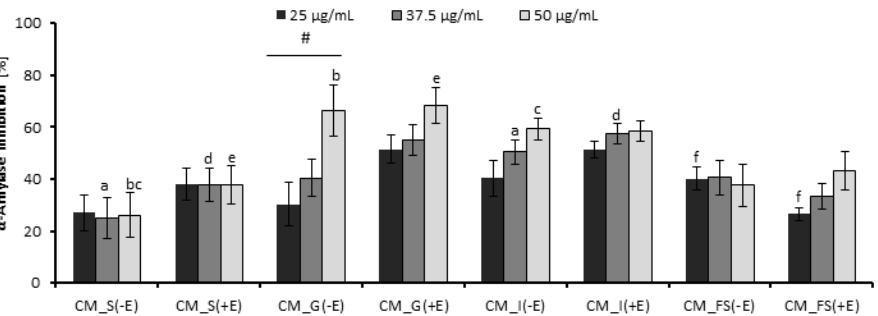
Figure 2. The inhibition of PL ( A ) and α -amylase ( B ) activities by fractions after gastrointestinal digestion of ethanolic-aqueous extracts from fruits of C. mas (CM) in vitro; CM_S-salivary fraction; CM_G-gastric fraction; CM_I-intestinal; CM_FS-fecal slurry/colon; (+E)-gastrointestinal pathway with digestive enzymes, ( – E)-gastrointestinal pathway without digestive enzymes. The statistical analysis was performed with the Mann – Whitney U test. The pairs of letters indicate the statistical significance between